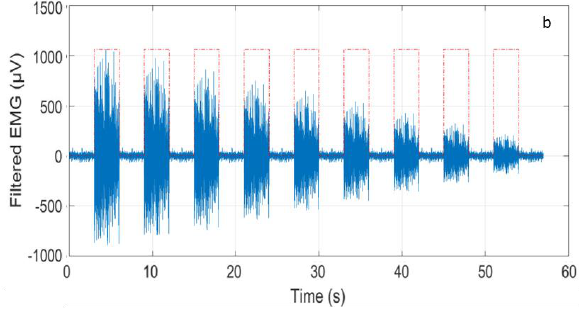
Figure 6. ( a ) The Root Mean Square (RMS) signal (blue) and factor j (green); and, ( b ) an example of the filtered EMG raw signal.